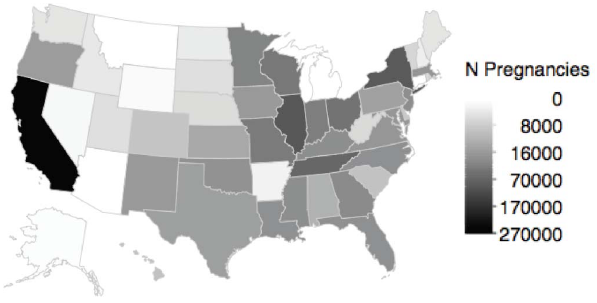
Figure 5. Number of pregnancies contributed to the base cohort by state; Medicaid Analytic eXtract,